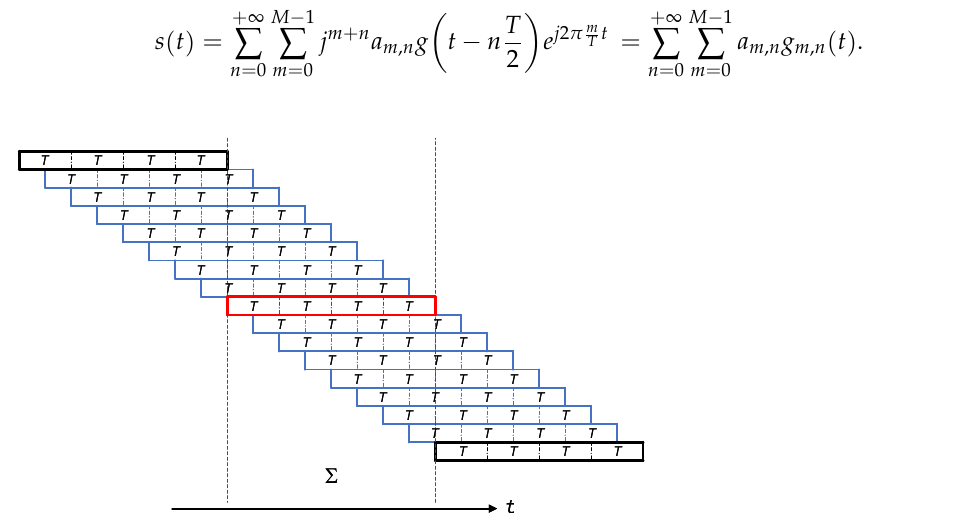
Figure 1. FBMC signal transmitted in the time domain with the “overlap-add” method. The red frame denotes the FBMC symbol to be received, and the blue frames stand for the FBMC symbols interfering with the red